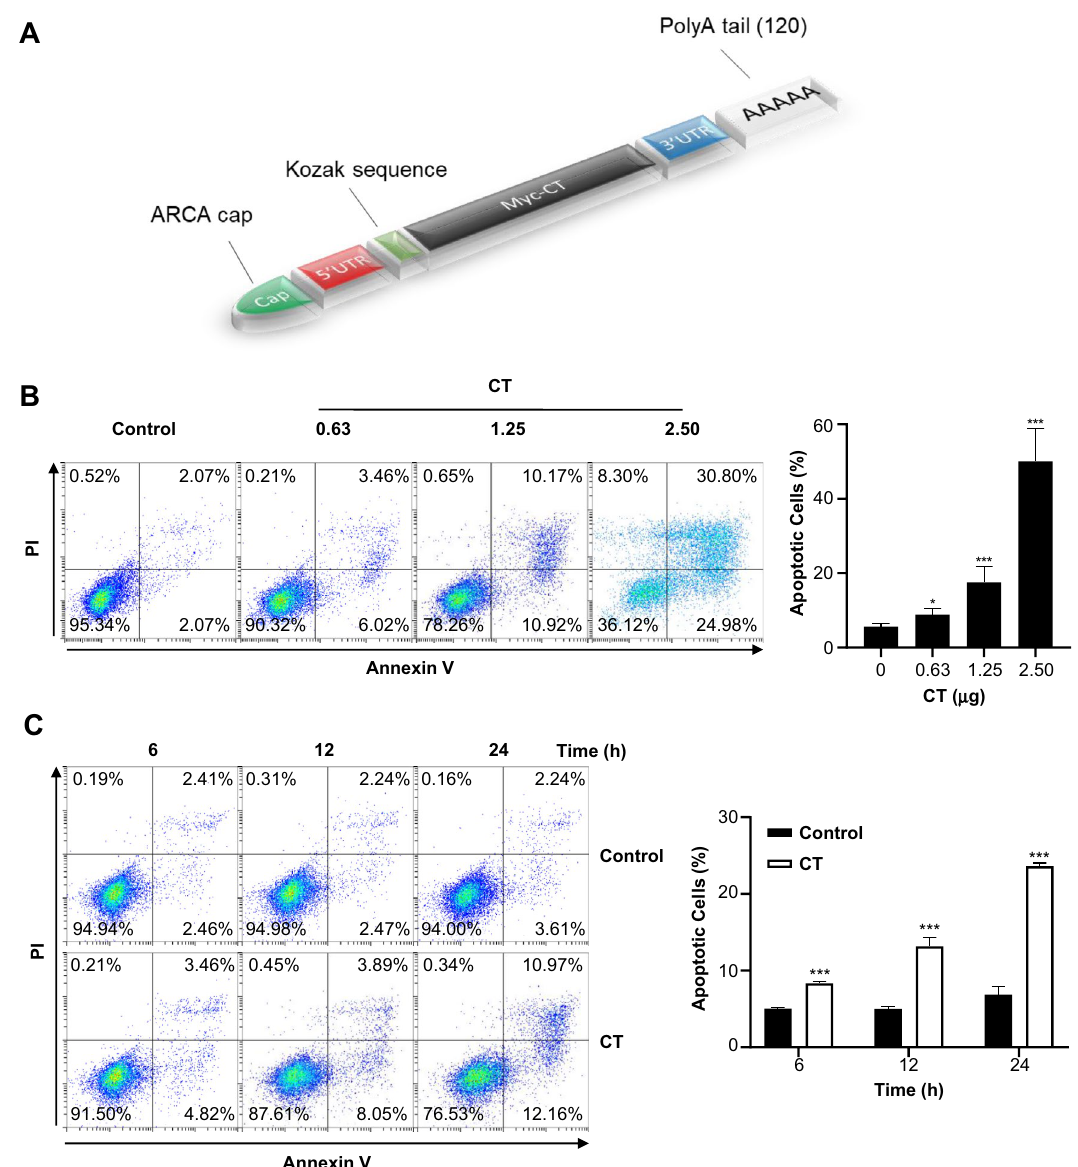
Figure 1. Suppression of MDA-MB-231 cell proliferation by CT mRNA. ( A ) CT-mRNA structure. CT mRNA was transcribed as a construct composed of the CT structural gene flanked with 5 ′ - and 3 ′ -UTRs. For stable translation in cancer cells, ARCA and a poly A tail were added to CT mRNA. ( B ) Flow cytometry analysis of the concentration-dependent cytotoxicity in MDA-MB-231 by CT transfection. Representative results were shown as quadrant analysis of fluorescence intensity of gated MDA-MB231 cells in annexin V-FITC and PI channels. MDA-MB231 cells were incubated without (control) or with CT at concentrations of 0.63, 1.25, 2.5 µg mRNA/5 × 10 5 cells for 24 h. CT mRNA efficiently induced apoptosis in MDA-MB231 cells. ( C ) Time- course cytotoxicity of MDA-MB-231 cells by CT mRNA transfection (1.25 μg). ( D ) Identification of apoptotic markers by treating with concentration-dependent manner for 12 h (left) and with time-dependent manner with 1.25 µg mRNA (right). Original blots are presented in Supplementary Information (Figure Raw data). ( E ) Visualization of apoptosis in MDA-MD-231 cells at 24 h post-CT transfection. The presence of phosphorylated H2AX (Alexa555-labeld antibody, red) in DNA in nucleus (Hoechst33342, blue) in MDA-MB-231 cells after CT-mRNA transfection were visualized by fluorescence microscopy. Percentages of viable, apoptotic, and necrotic cells without (control) or with CT treatment were represented as the mean of three experiments (n = 3, Student’s t-test * p < 0.05, ** p < 0.01, *** p < 0.001, significantly different from the